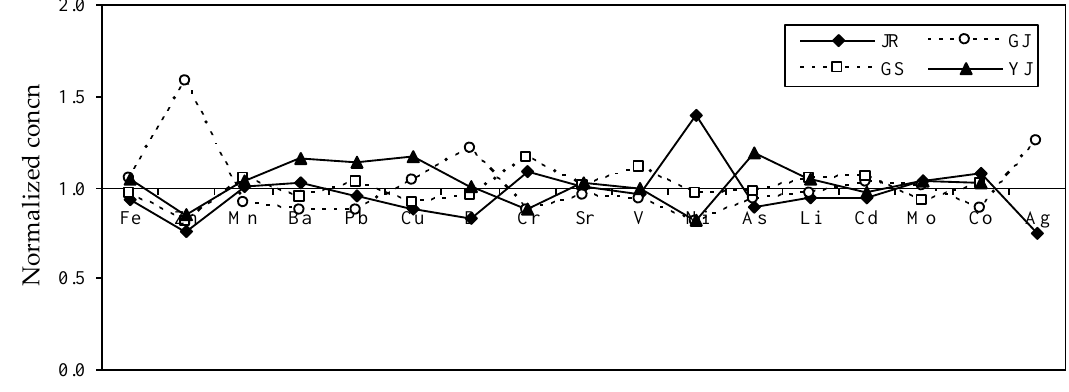
FIGURE 5. Normalization of the mean metal concentration in TSP among the four sites in this